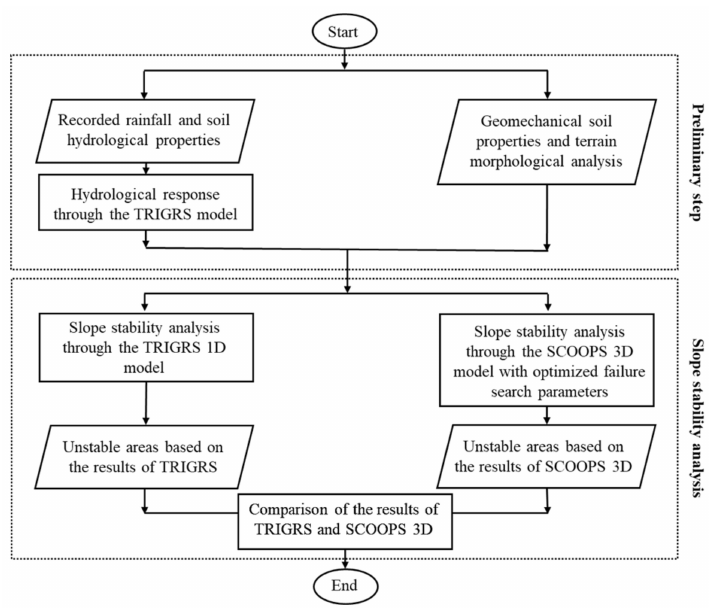
Figure 1. Description of the methodology.